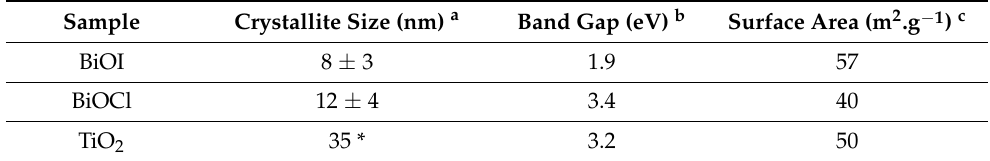
Table 1. Physicochemical properties of photocatalysts.